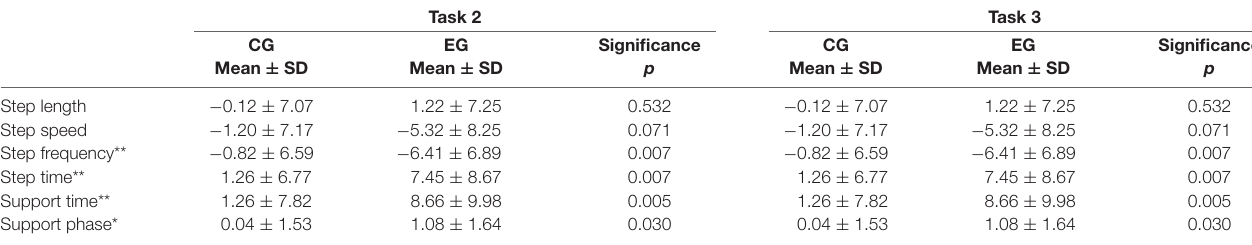
TABLE 3 | The statistics of the dual-task cost during Task 2 and Task 3.